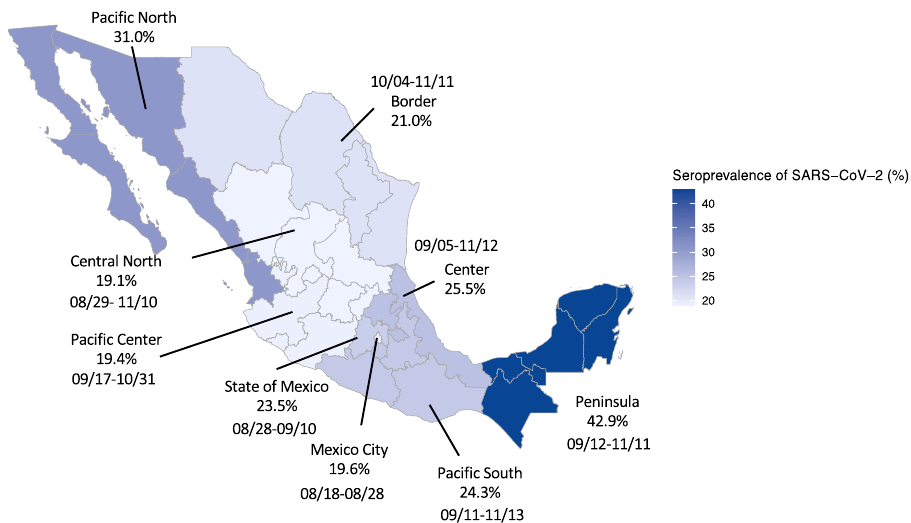
Fig. 1 Seroprevalence of SARS-CoV-2 across nine regions in